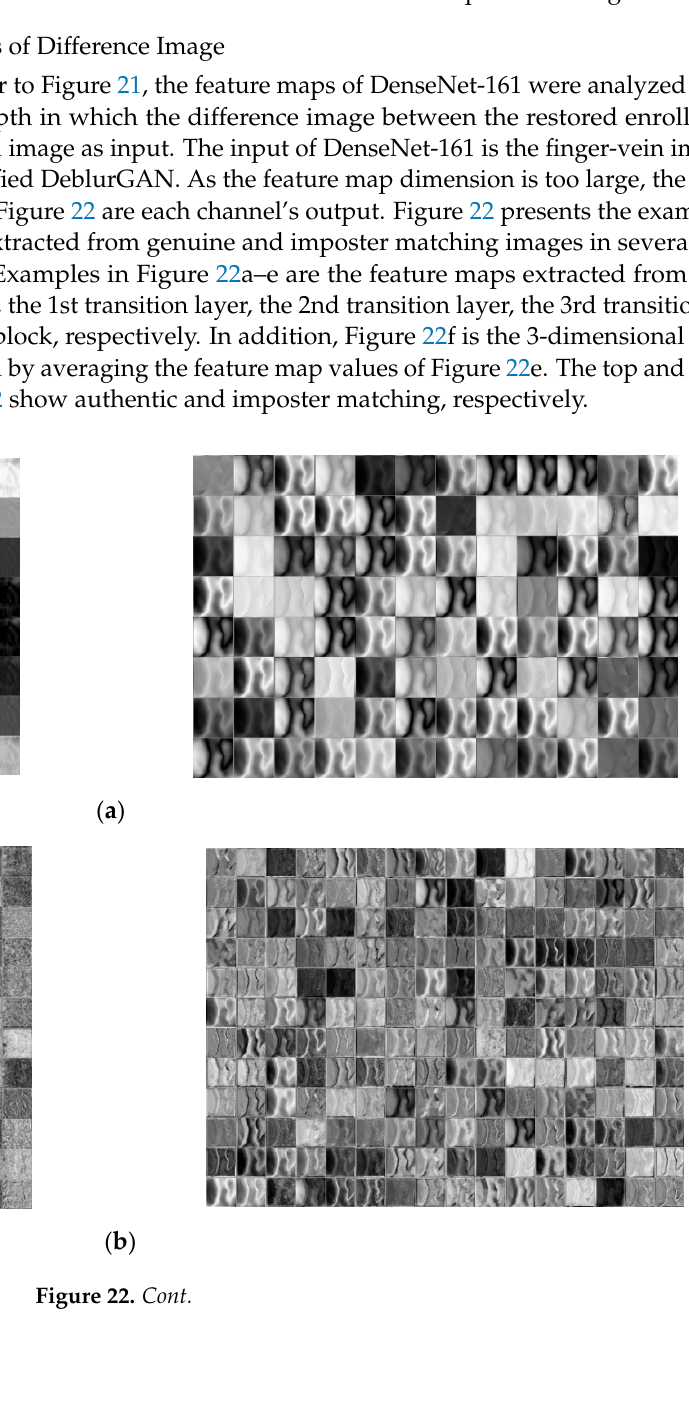
29 of 34 Figure 21. Comparisons of the class activation maps between the original and restored images. ( a , b ) are examples of authentic and imposter images, respectively. Images on the left of ( a , b ) are the